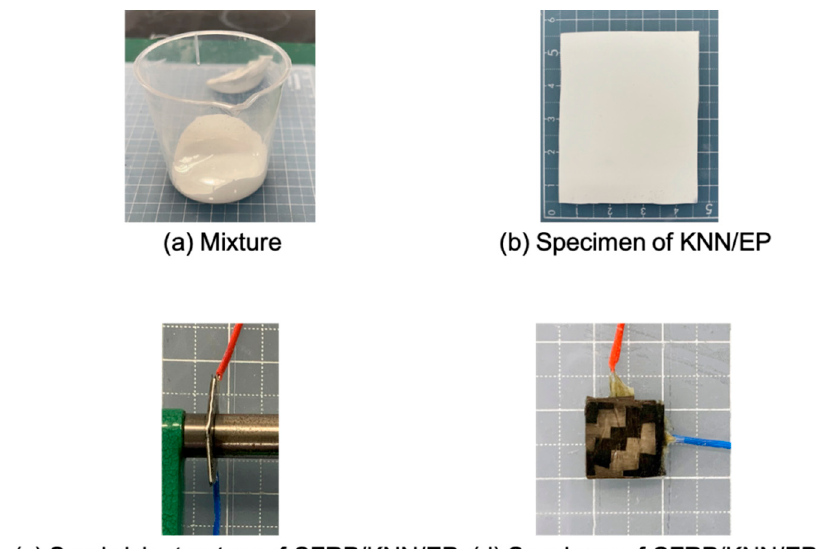
Figure 2. Images during fabrication of the specimens: ( a ) the piezoelectric nanoparticle and epoxy resin with hardener was entirely mixed; ( b ) the KNN/EP specimen was homogeneous, and the molding quality was relatively good. Before spreading the mixture on the mold, it was necessary to coat the mold with release wax; ( c ) the sandwich structure of the CFRP/KNN/EP composite material; ( d ) wires embedded in the upper and lower CFRP electrodes.